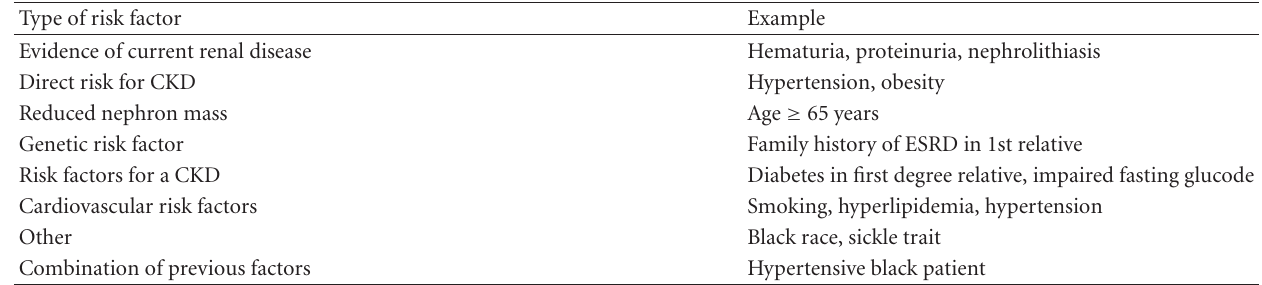
Table 1: Risk factors associated with complex living